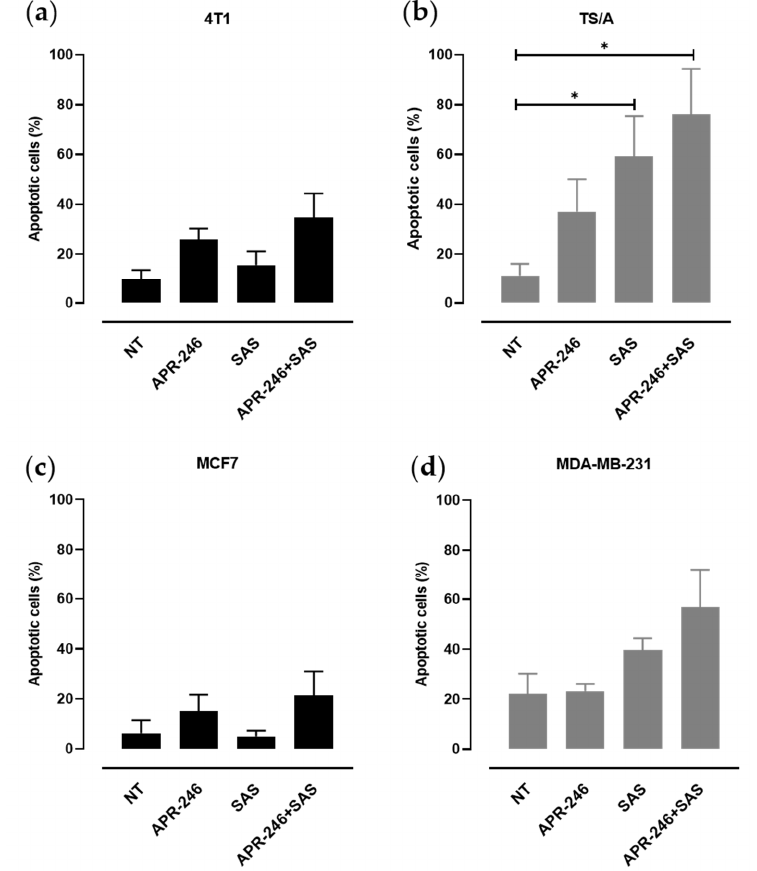
Figure 2. Quantitative analysis of apoptosis induced by APR-246, SAS, or the combinatorial treatment. Values of apoptotic cells for ( a ) 4T1, ( b ) TS/A, ( c ) MCF7, and ( d ) MDA-MB-231 treated or not with APR-246 (5 µM) and/or with SAS (100 µM) for 24 h or not treated (indicated as NT). Data are presented as the mean ± SEM of the percentage of apoptotic cells. * p < 0.05; Student’s t test.